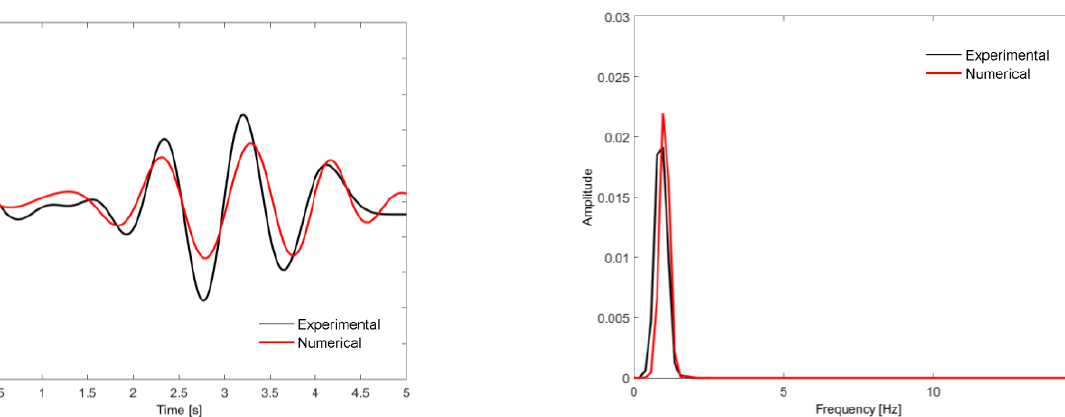
Figure 22. Comparison of the time records and respective auto spectra of the vertical acceleration of point A of the seat base from vehicle BAS, obtained experimentally and numerically, for the passage over São Lourenço bridge at a speed of 180 km/h .